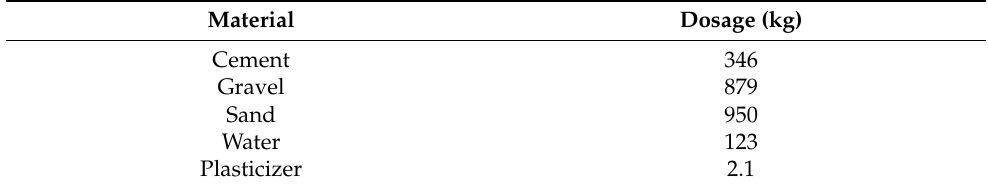
Figure 1. Image of the nine test pieces produced for compression testing. Table 2. Dosage of the concrete used.